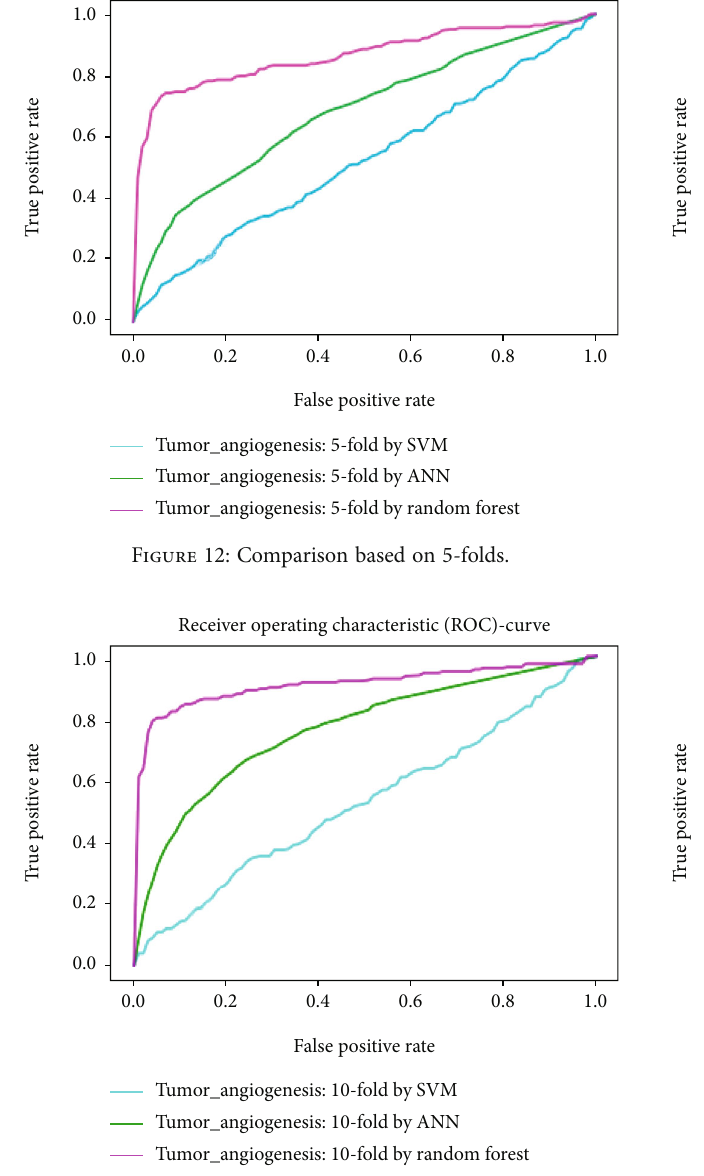
Figure 15: Comparison based on independent